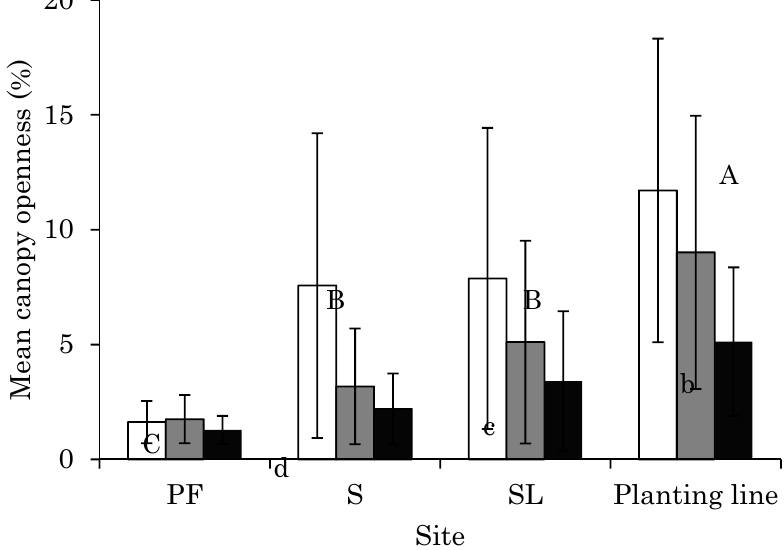
Figure 4. Mean canopy openness (CO) at each site and planting line measured in 2011 (blank bars), 2012 (shaded bars), and 2014 (filled bars). Error bars indicate the standard deviation (S.D.). Different capital and small letters indicate a statistical difference among the three sites and planting line in 2011 and 2014 (Steel–Dwass test, p < 0.05).